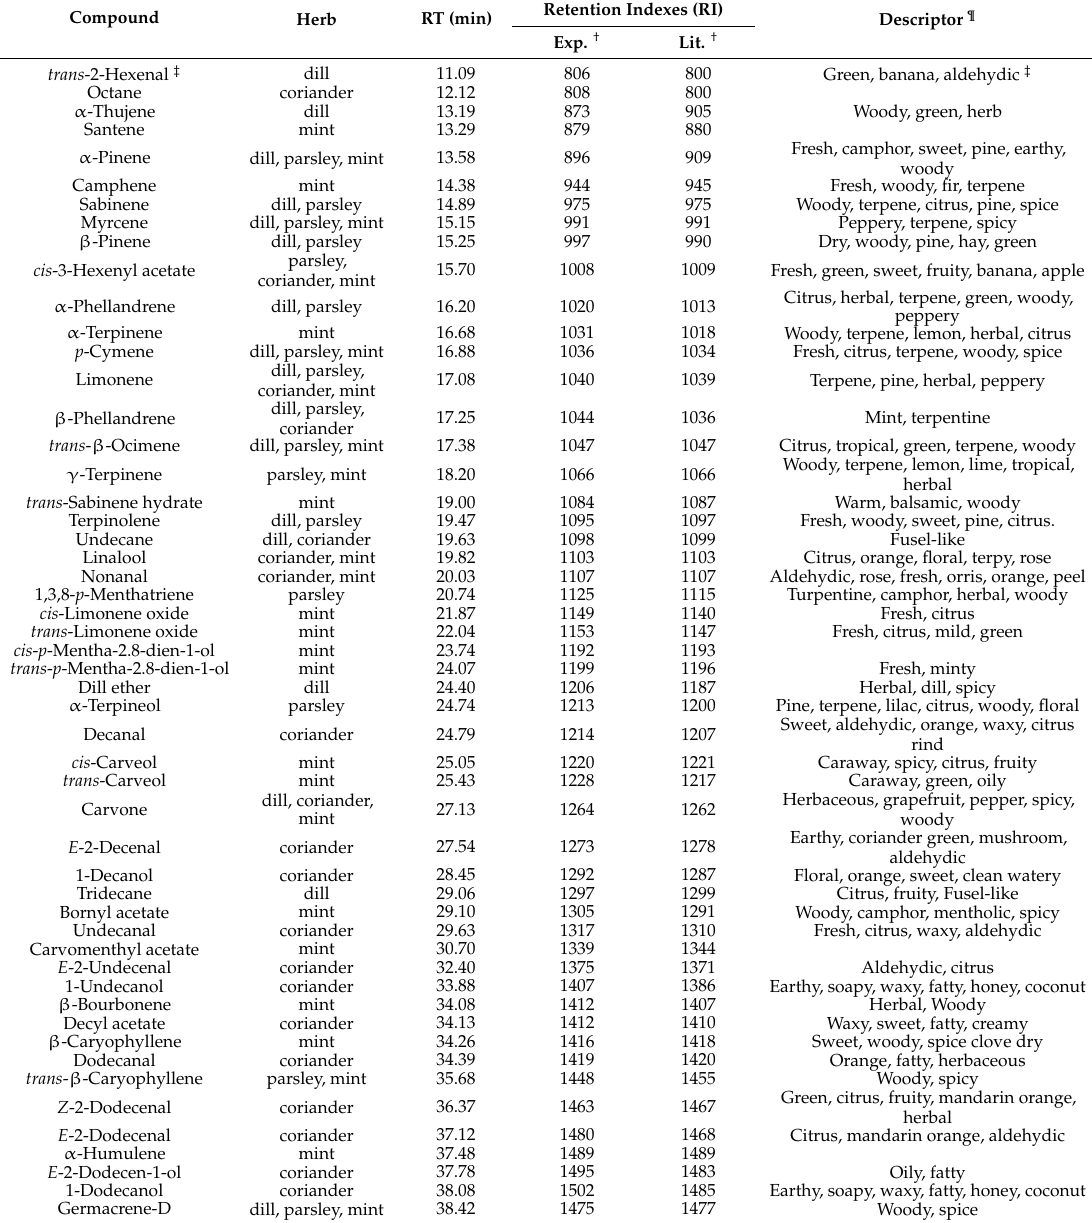
Table 1. Identification of essential oils found in dill, parsley, coriander, and mint